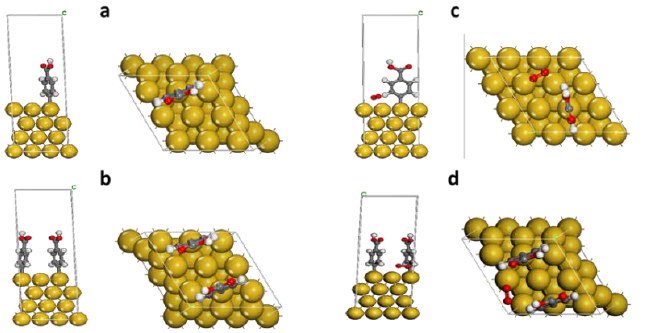
Figure 6. Optimized geometries of gold surfaces grafted with carboxyphenyl groups in absence and presence of oxygen molecule (level of theory: GGA/DND/TS). ( a ) Au-CP; ( b ) Au-CP/O 2 ; ( c ) Au-2CP; ( d ) Au-2CP/O 2 .